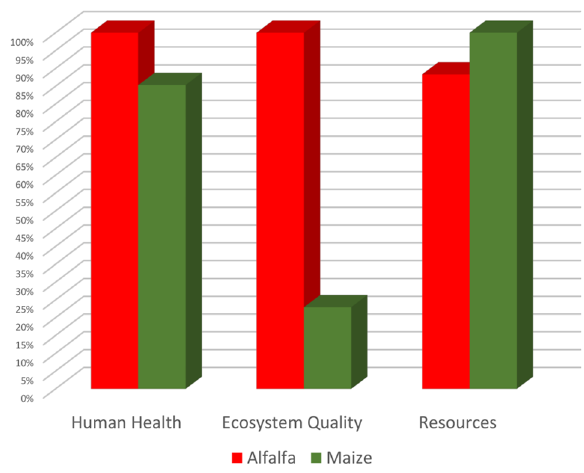
Figure 7. Comparison between the two crops damage assessment phase.